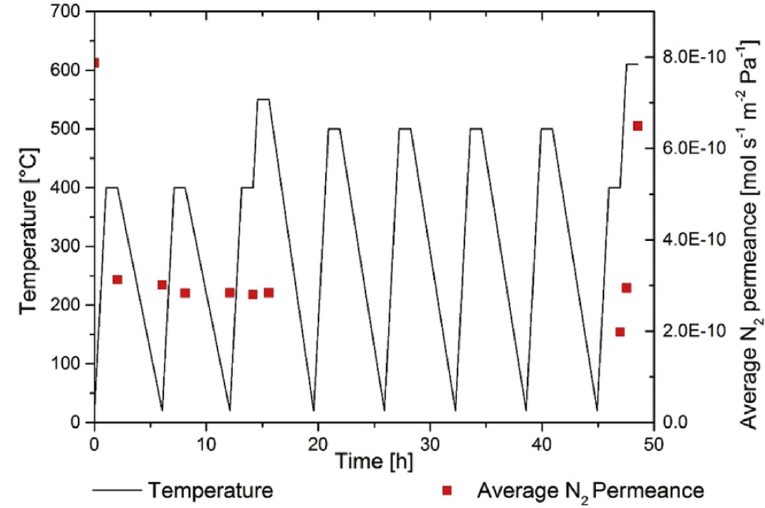
Figure 20. N 2 leakages as a function of thermal cycles for the ceramic supported Pd-based membrane with a pressure difference of 3 bar. Cooling and heating in N 2 atmosphere [39].